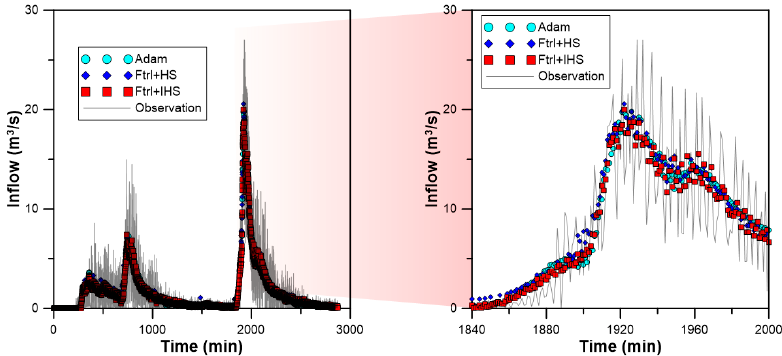
Figure 7. Comparison of prediction for each method.